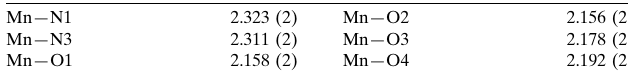
H N ) - 10 9 2 2 O, consists 2 cations,